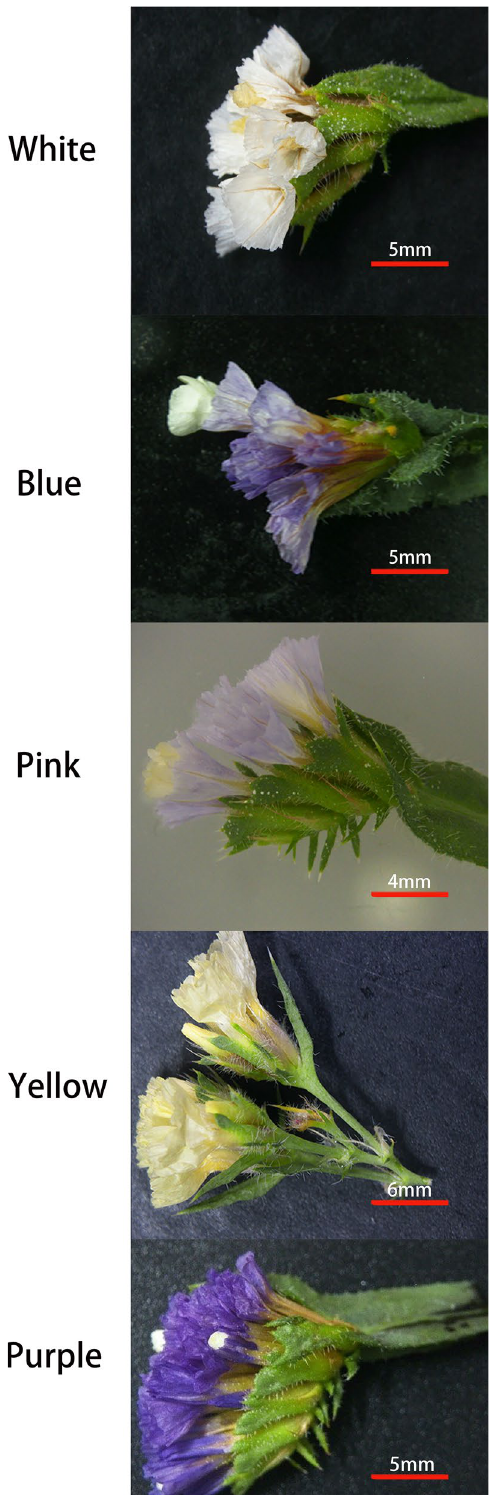
Figure 1. Flower color in different varieties of Limonium sinuatum after 6 months of growth. The photographs show flowers from the White , Blue , Pink , Yellow , and Purple varieties. Different colors indicates the calyx’s